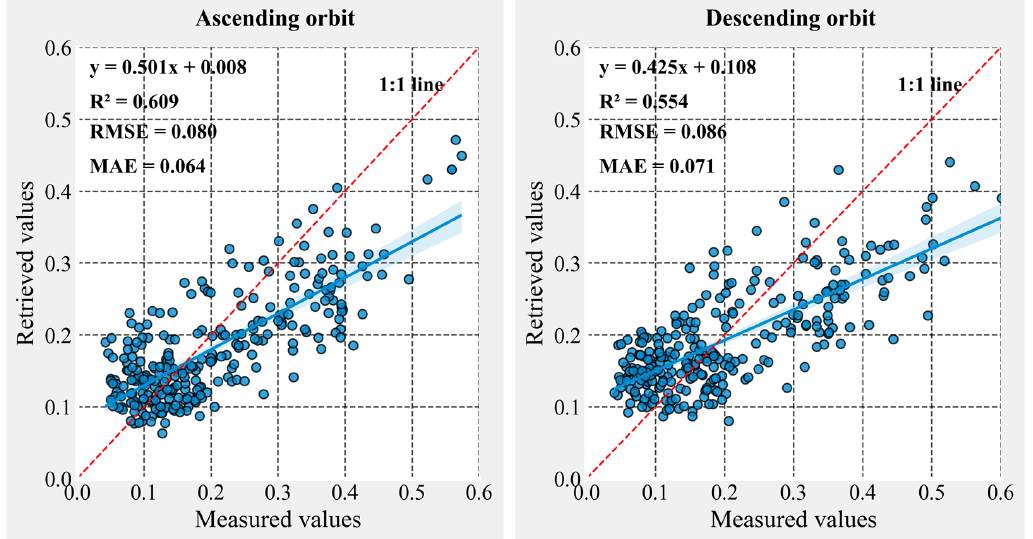
Figure 7. Comparison between measured and retrieved soil moisture values of Naqu network (The blue line is fitted line, and the red line is 1:1 line).